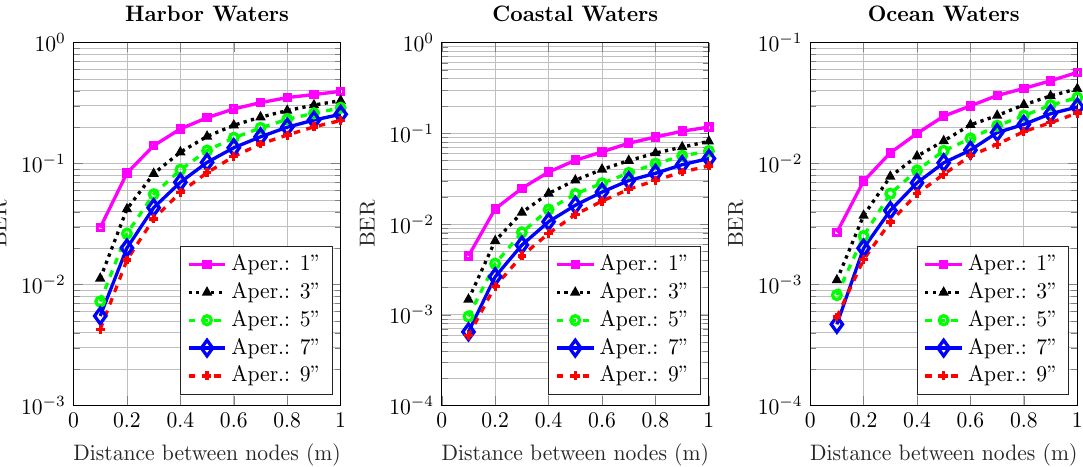
Figure 9. Effect of increasing transmission distance and aperture on the BER performance of harbor, ocean, and coastal waters for 90 ◦ receiver